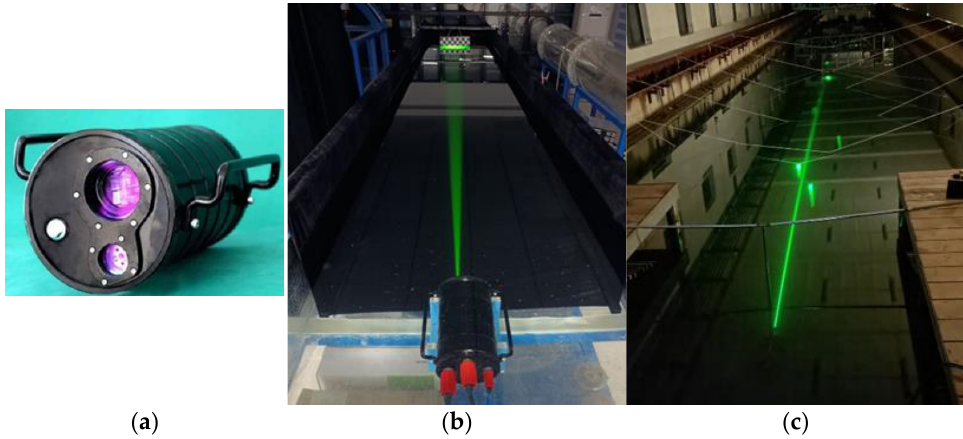
Figure 7. The PLRGI system and experimental scenario: ( a ) the PLRGI system used in the experiments; ( b ) water tank in lab; ( c ) boat tank.